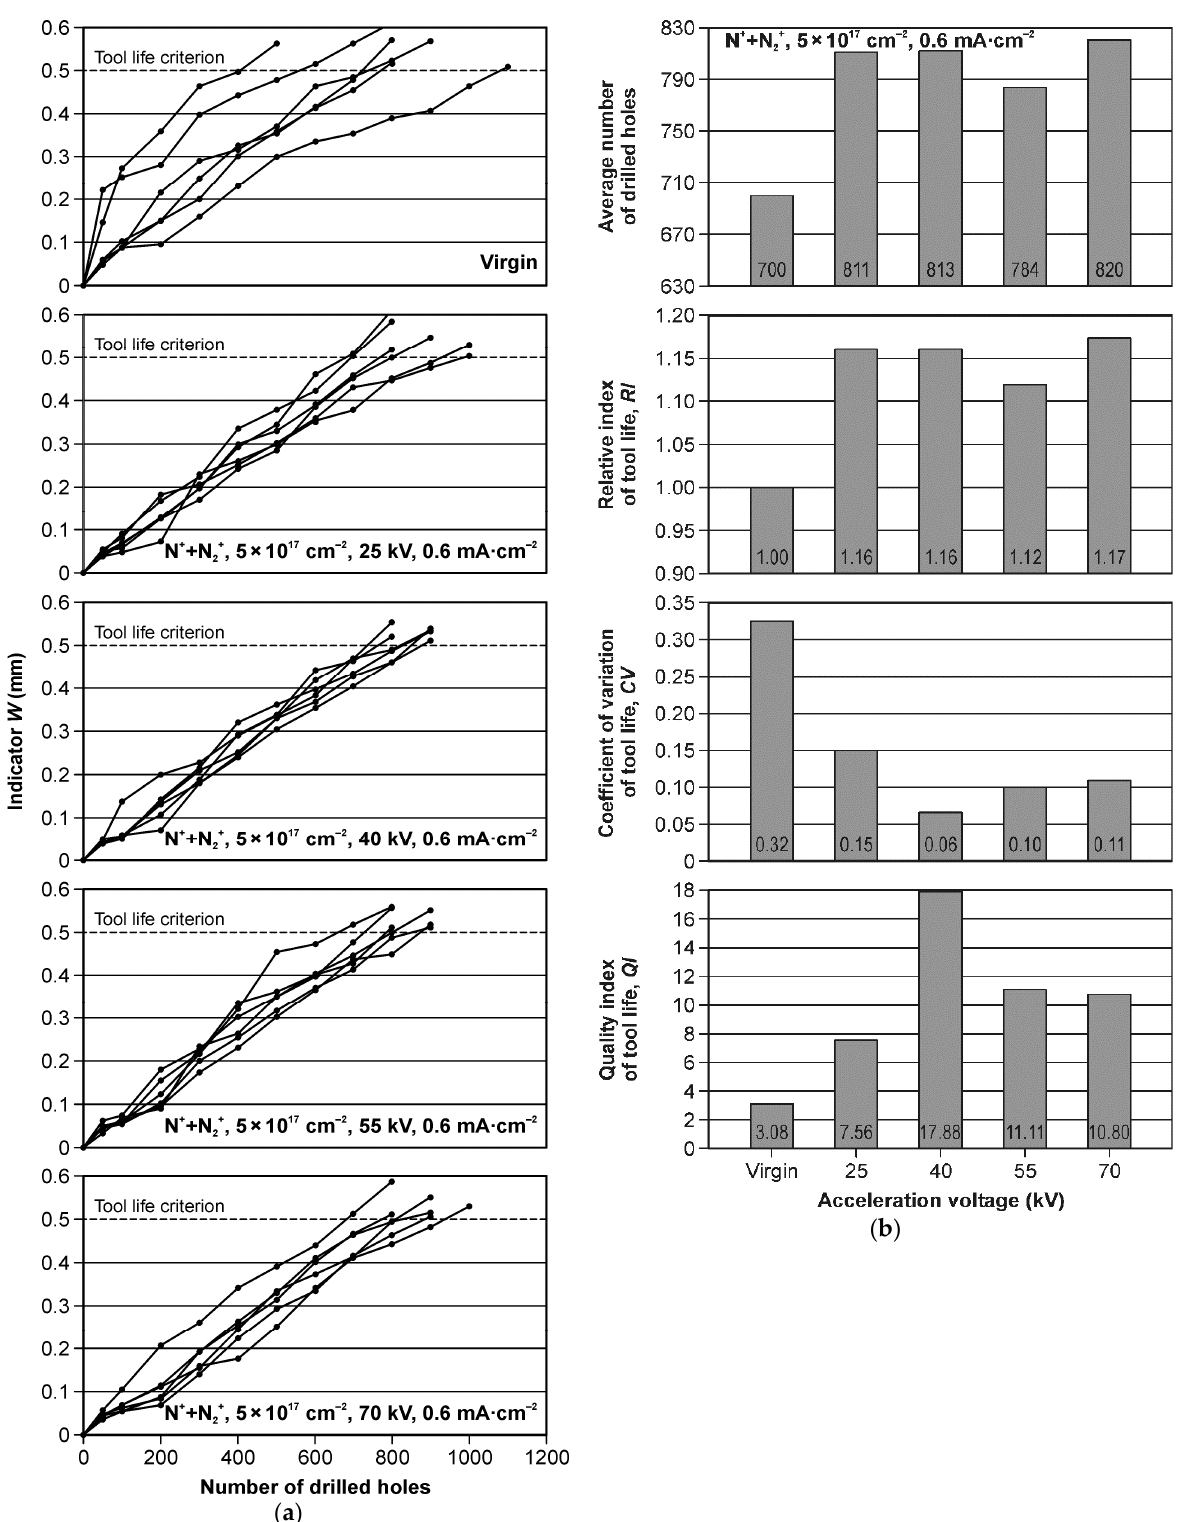
Figure 8. ( a ) The wear curves of the tested HSS drills; ( b ) the statistical values of tool